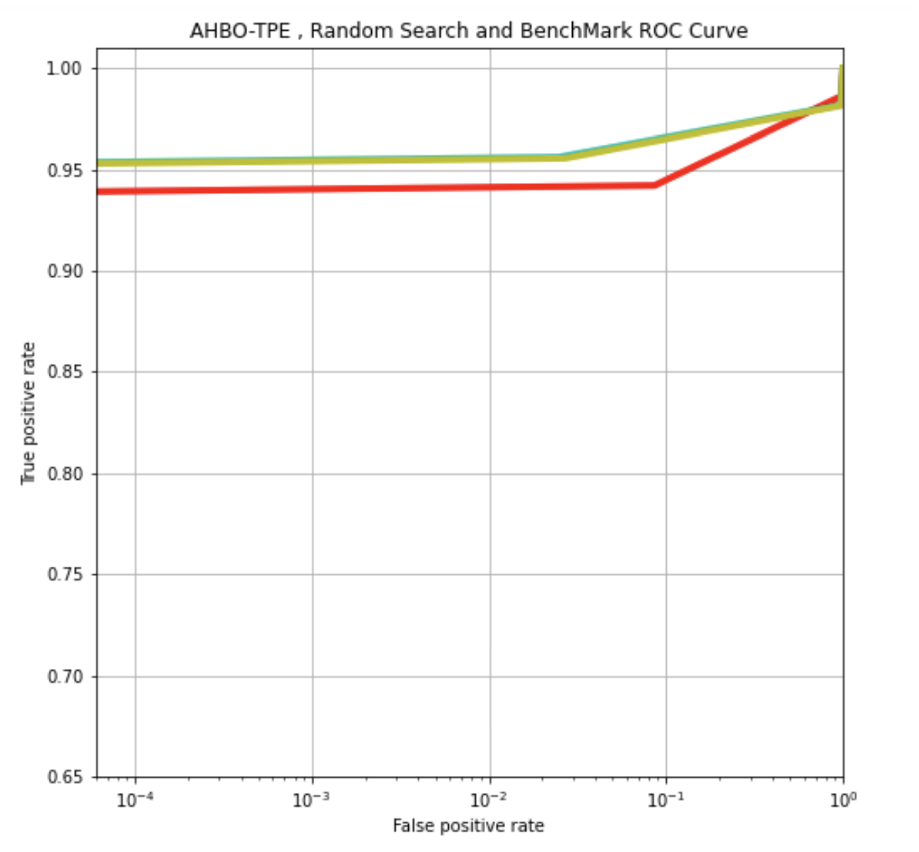
Figure 2. ROC AUC Comparison for AHBO-TPE (Cyan), Random Search (Yellow), and Default Benchmark Model (Red) applied to the Ember